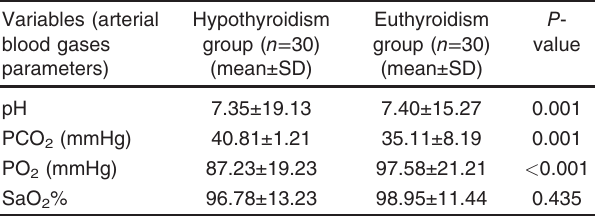
Table 7 Comparison of arterial blood gases parameters between hypothyroid and euthyroid groups